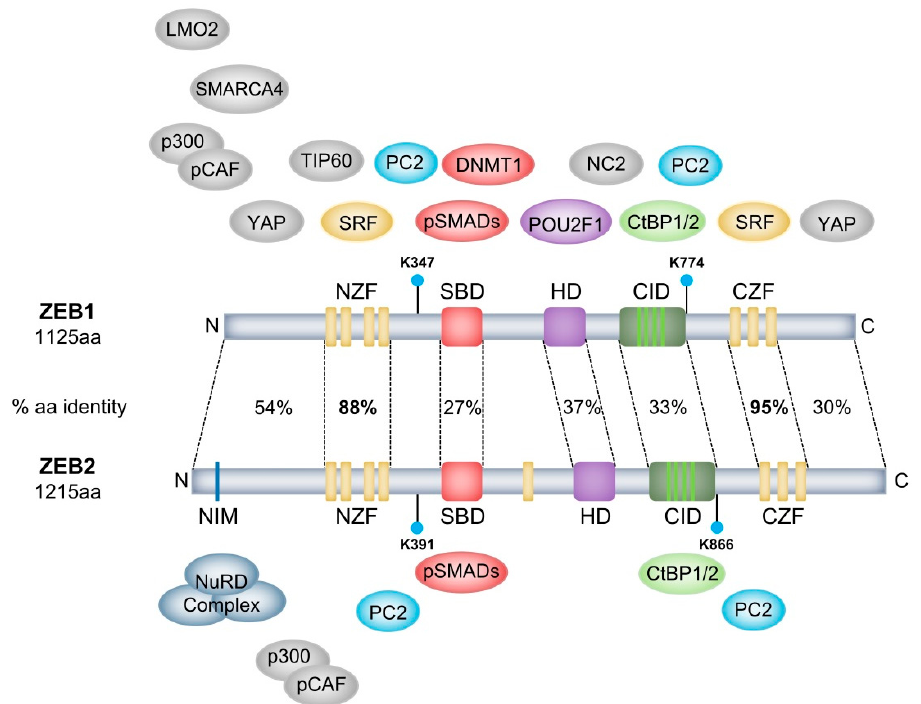
Figure 1. Human ZEB1 and ZEB2 protein structure and interaction partners. Percentages depict the amino acid (aa) sequence similarity. Only interaction partners of which the binding site on ZEB1 / ZEB2 has been studied are depicted. For a full list of all interaction partners, see Tables 1 and 2. Interaction partners have an identical colour as their respective binding domain on ZEB1 / ZEB2. PC2 (in blue) binds at and sumoylates Lys-347 and Lys-774 of ZEB1 and Lys-391 and Lys-866 of ZEB2 (cyan circles). Brown / Yellow coloured interaction partners have interaction sites that are defined as bigger region. The NuRD complex is a multi-protein complex of which the exact interaction partner with ZEB2 is not defined.